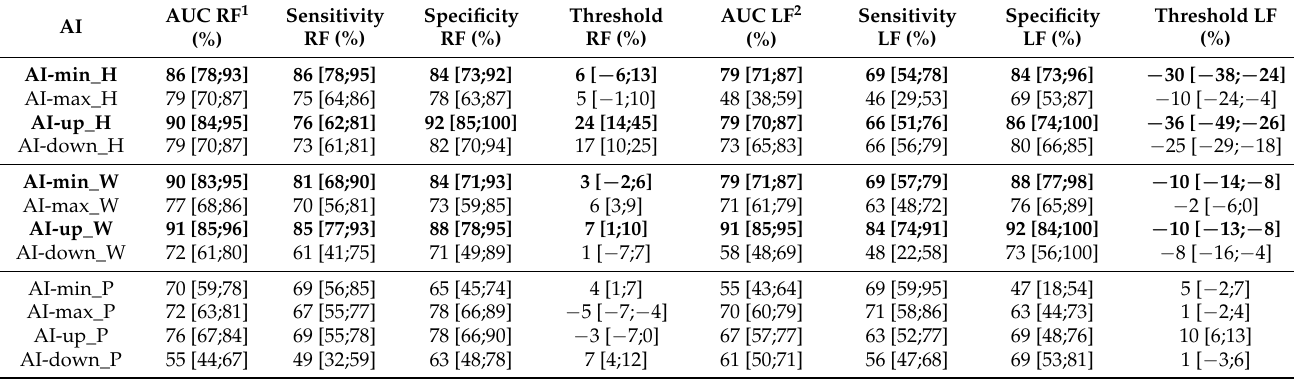
RF 1 —right forelimb, LF 2 —left forelimb. Results for which the sum of sensitivity and specificity is over 150% for both sides are in